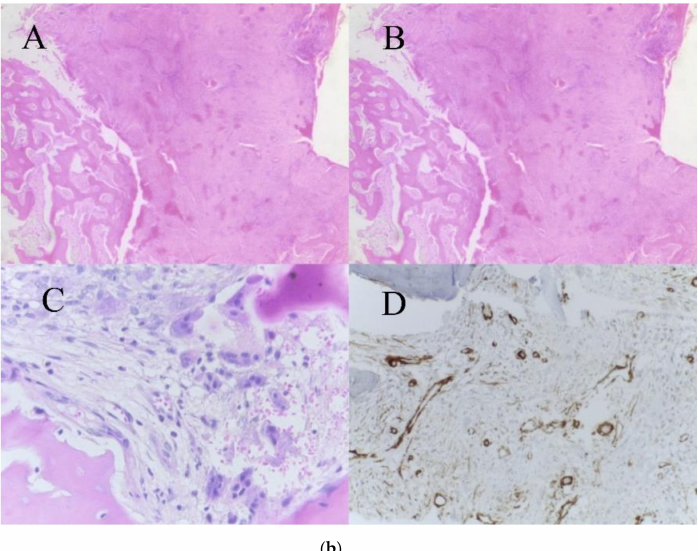
Figure 3. ( a )—Trichrome Masson staining: bone trabeculae with medullar fibrosed tissue (arrow show a fragment of bone sequestrum). ( b )—Biopsy Hematoxylin-eosin staining: eosinic deposits at 40 × magnification (A), at 100 × eosinic deposits and (B) 400 × with giant cells (C); Alpha smooth muscle actin ( α -SMA) staining showing fusiform cells (D).